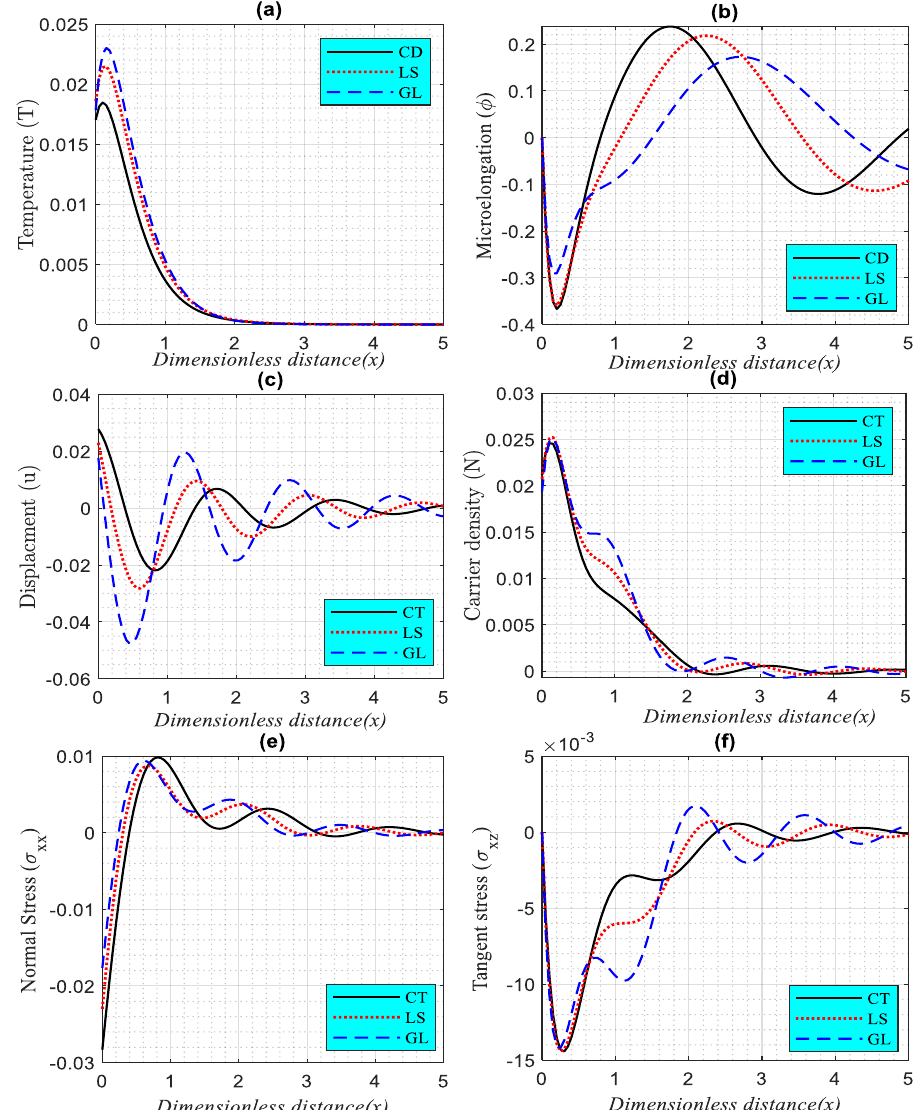
Figure 2. ( a–f ). The variation of the main physical fields versus the horizontal distance according to the differences in thermal relaxation times under the effect of rotation parameter.